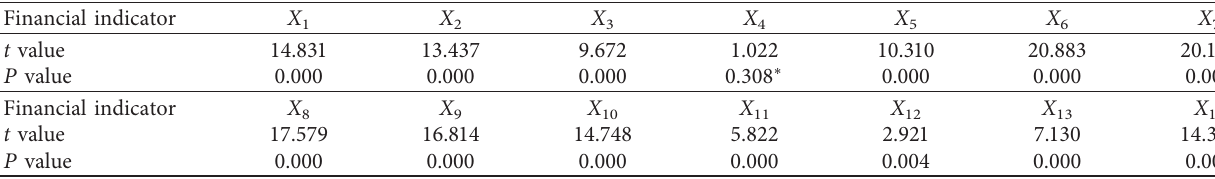
Table 2: t -test of financial indicators.